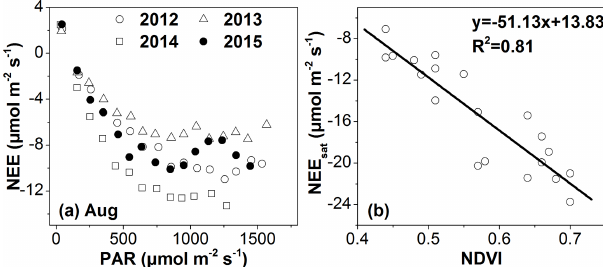
Figure 2. The relationship between daytime NEE and PAR (a) for August from 2012 to 2015. The NEE and PAR data were averaged with PAR bins of 100µmolm − 2 s − 1 . (b) The relationship between NEE sat and NDVI on a monthly